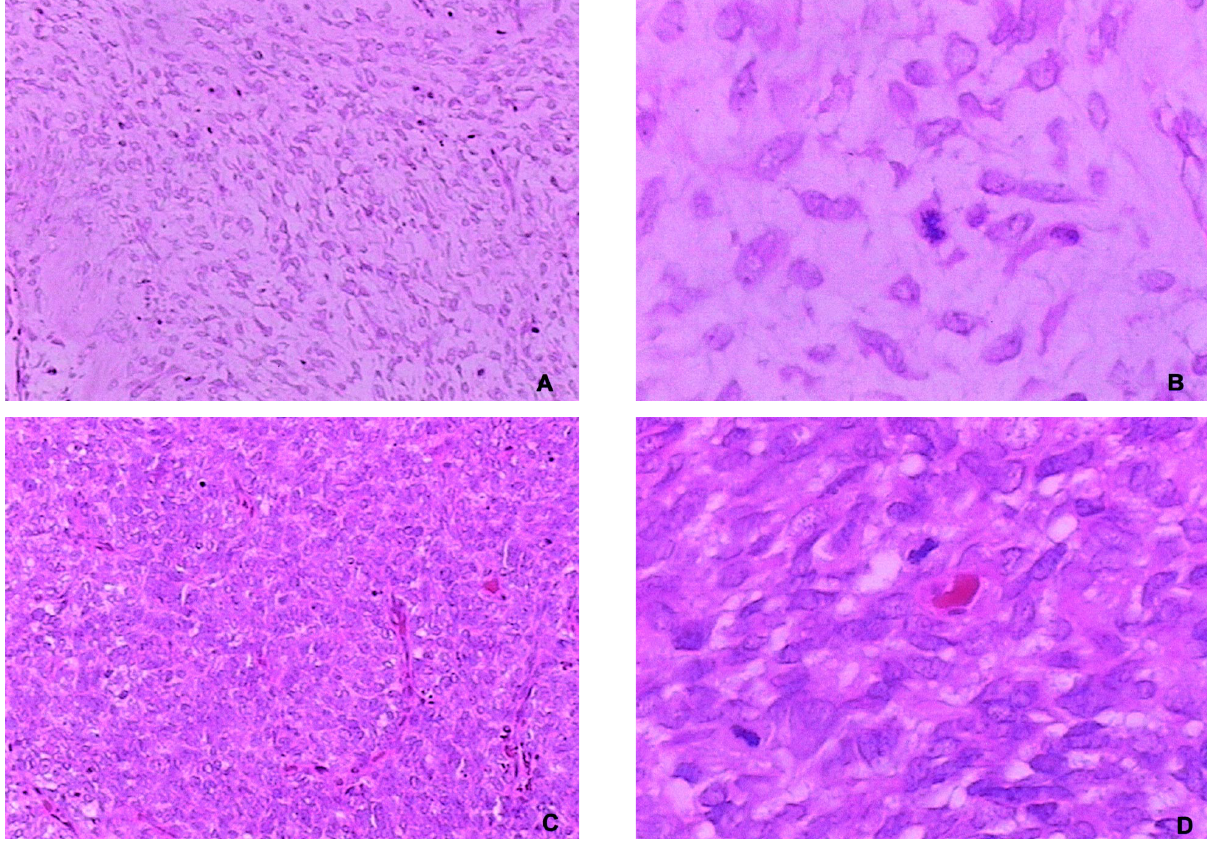
Figure 3 – Histology of incision biopsy showing a spindle cell component (monophasic fibrous) (A and B), and small round cells component (poorly differentiated) (C and D) (HE, A and C, X33; B and D, X132).